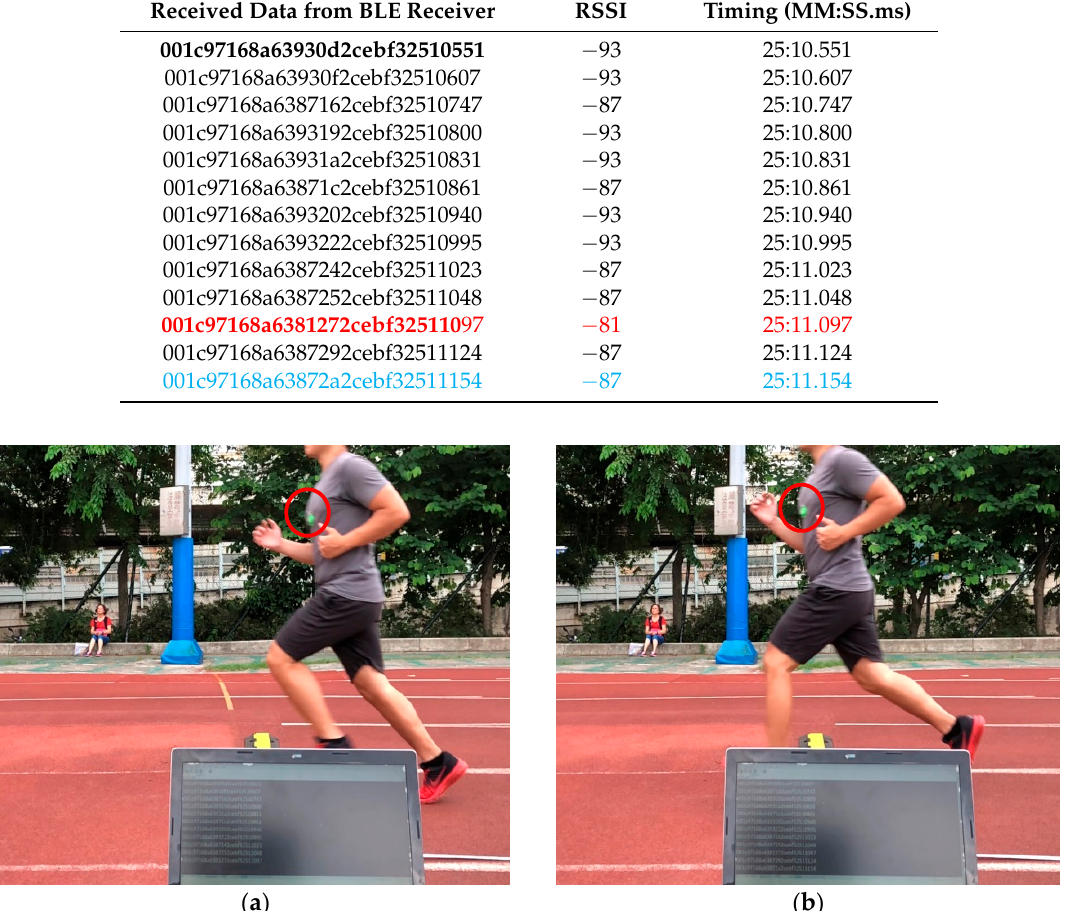
Table 1. One dynamic experiment in which the BLE Tag was on the chest.